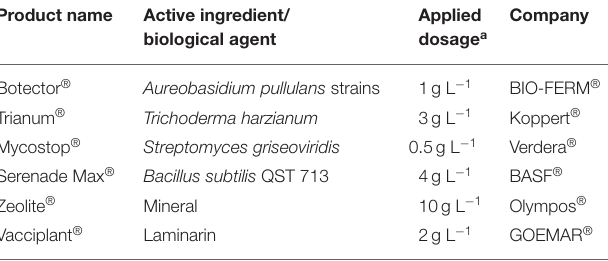
TABLE 1 | Commercial biopesticides and biostimulants used in the present study, active ingredients and applied doses according to manufacturer’s instructions and